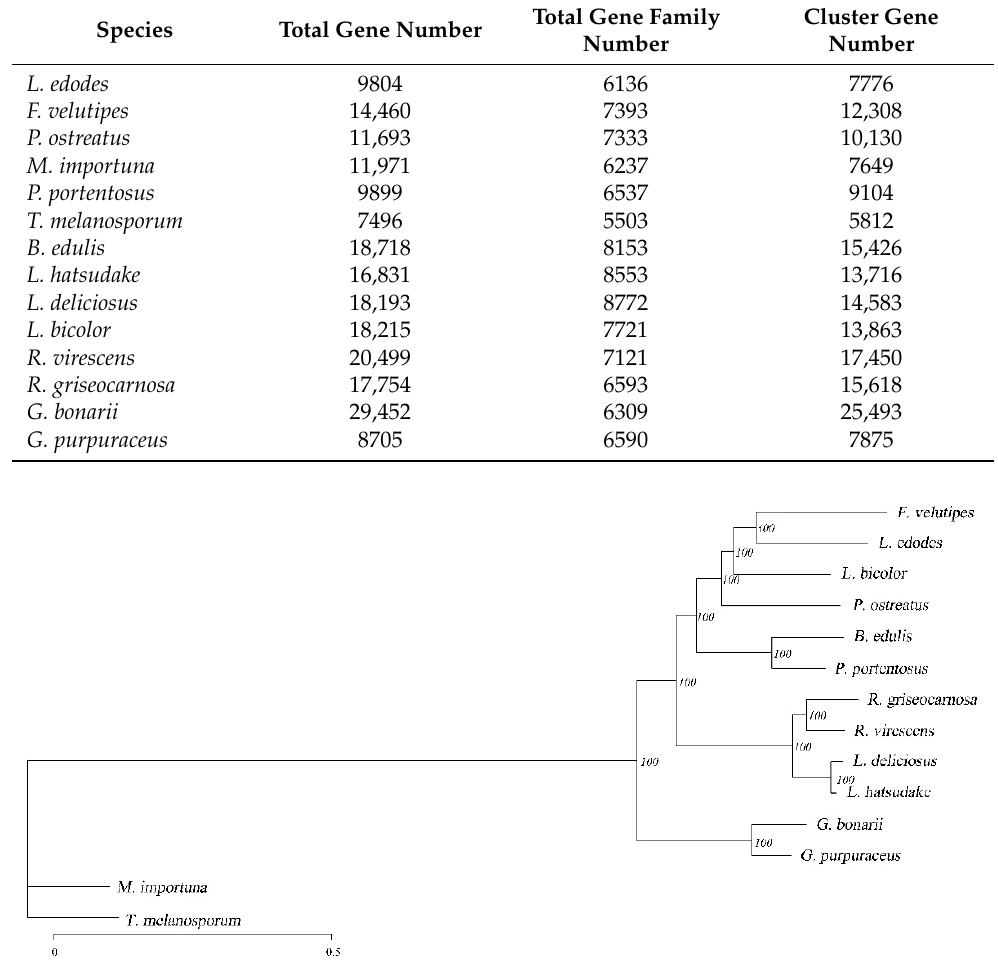
Figure 6. Maximum likelihood phylogenetic tree based on single-copy ortholog genes.